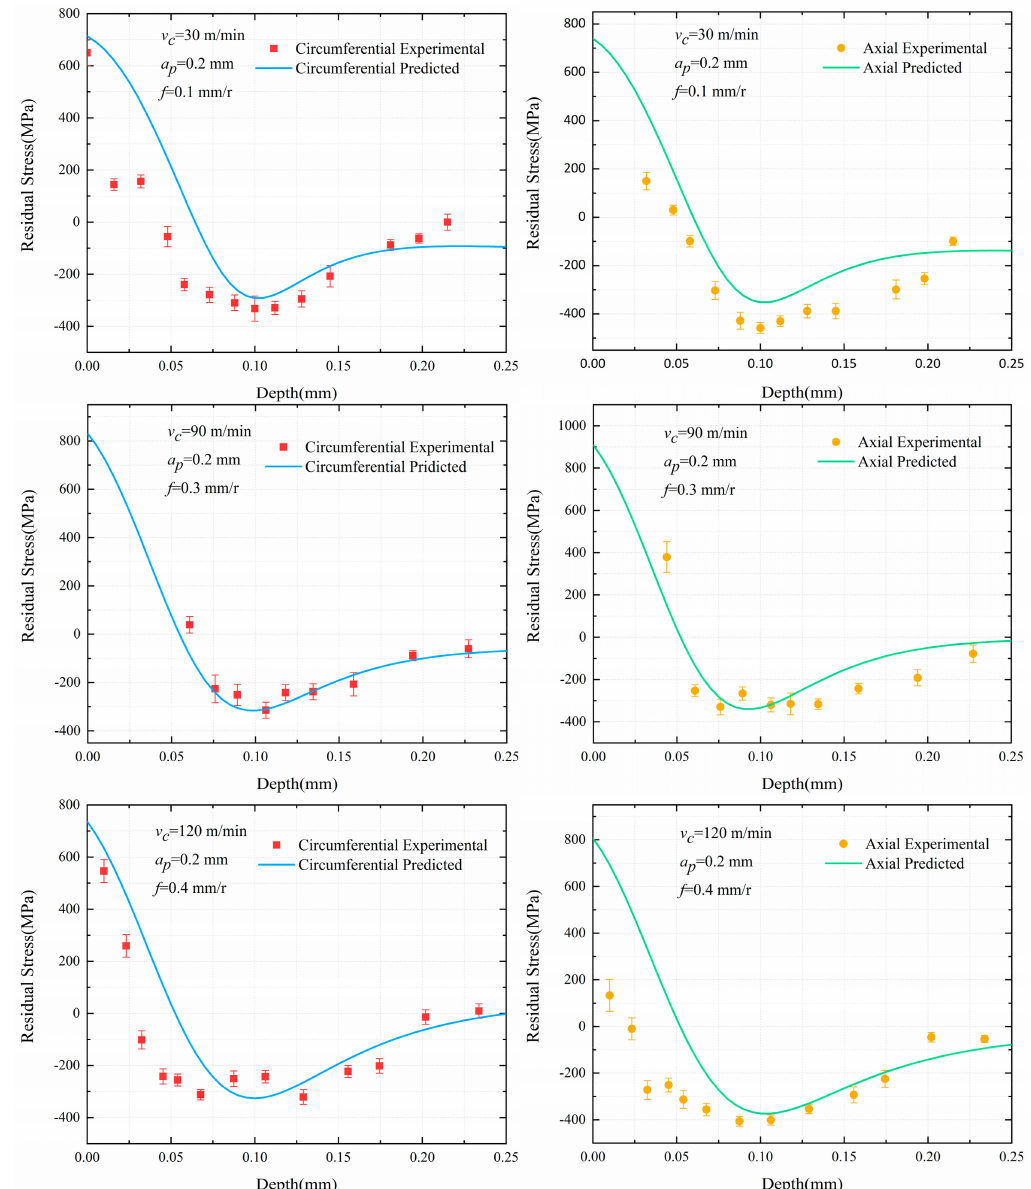
Figure 11. The comparisons of measured and predicted residual stress